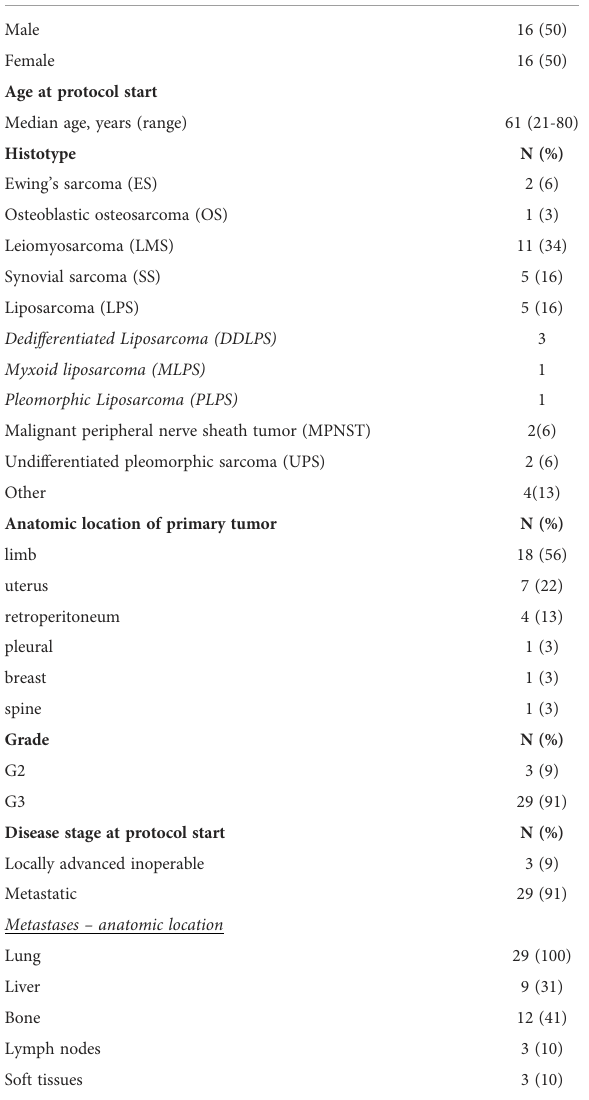
TABLE 1 Patients ’ demographics and tumor